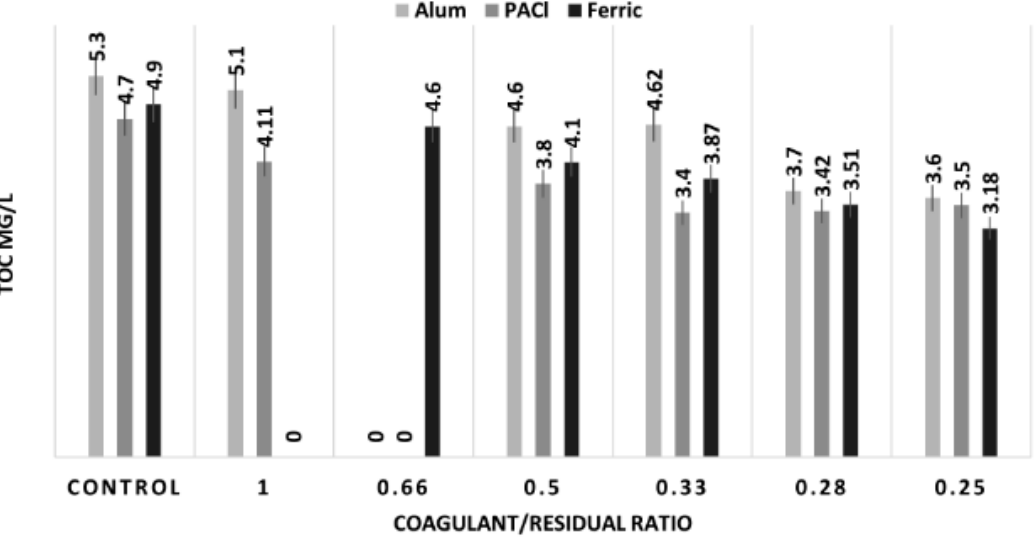
Figure 3. Ground water TOC removal using selected five C/R ratios .